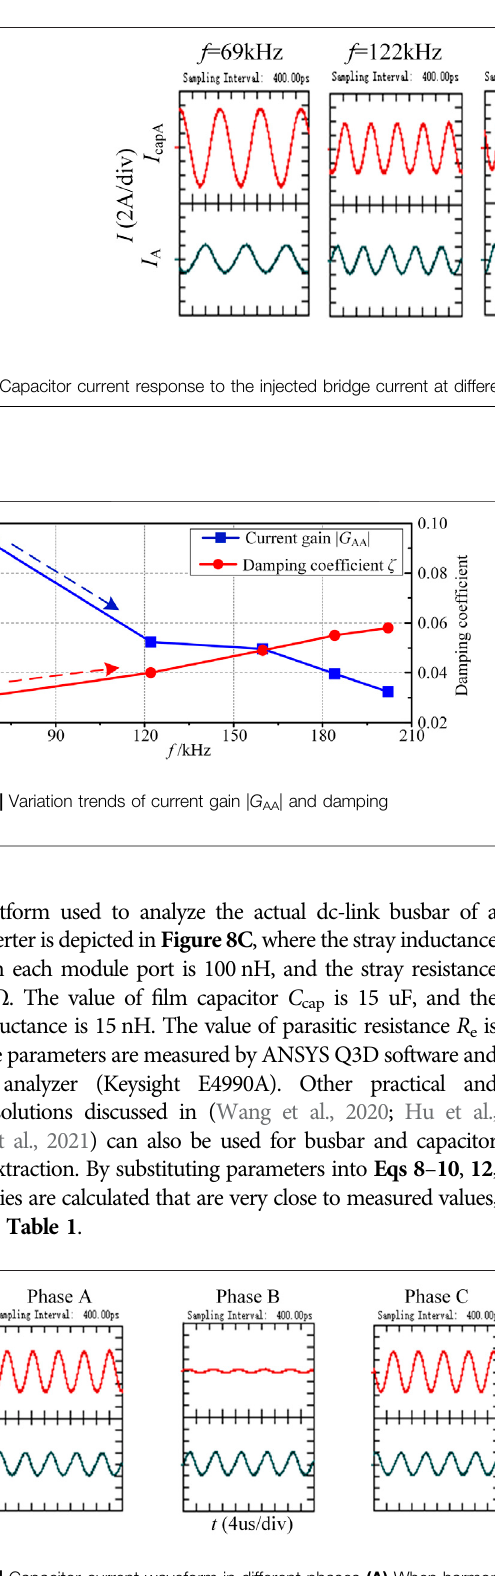
Frontiers in Energy Research |